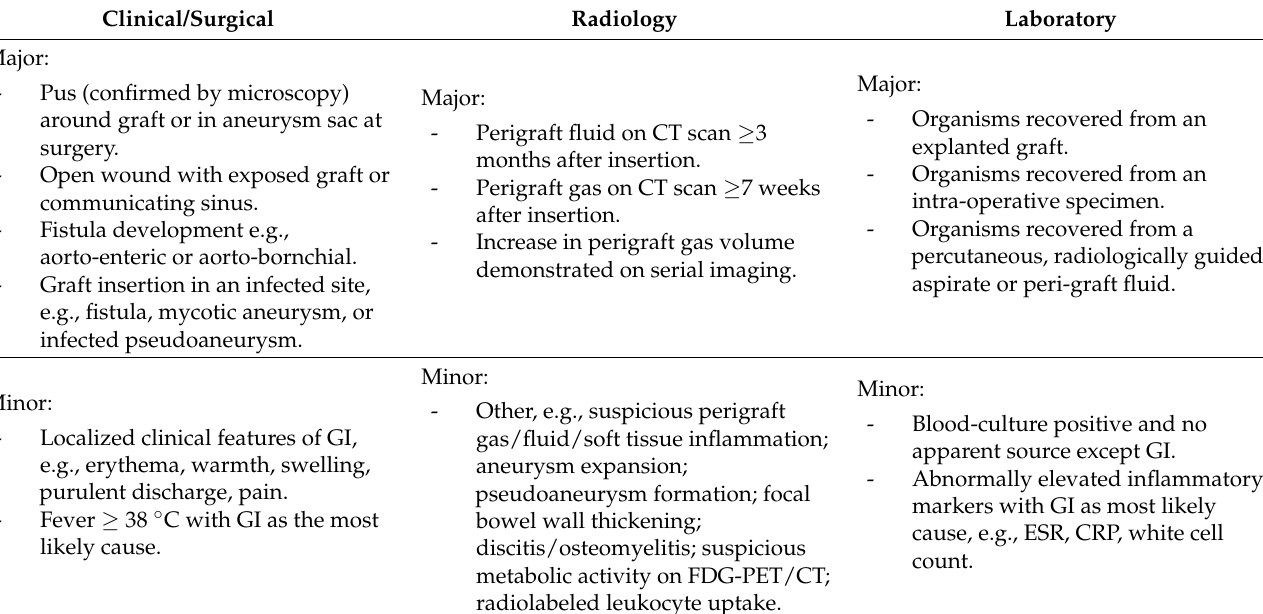
Table 1. Management of Aortic Graft Infection Collaboration (MAGIC) criteria